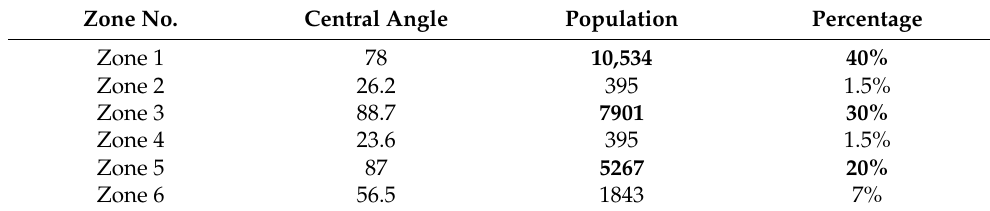
Table 3. Distribution of population in different zones.